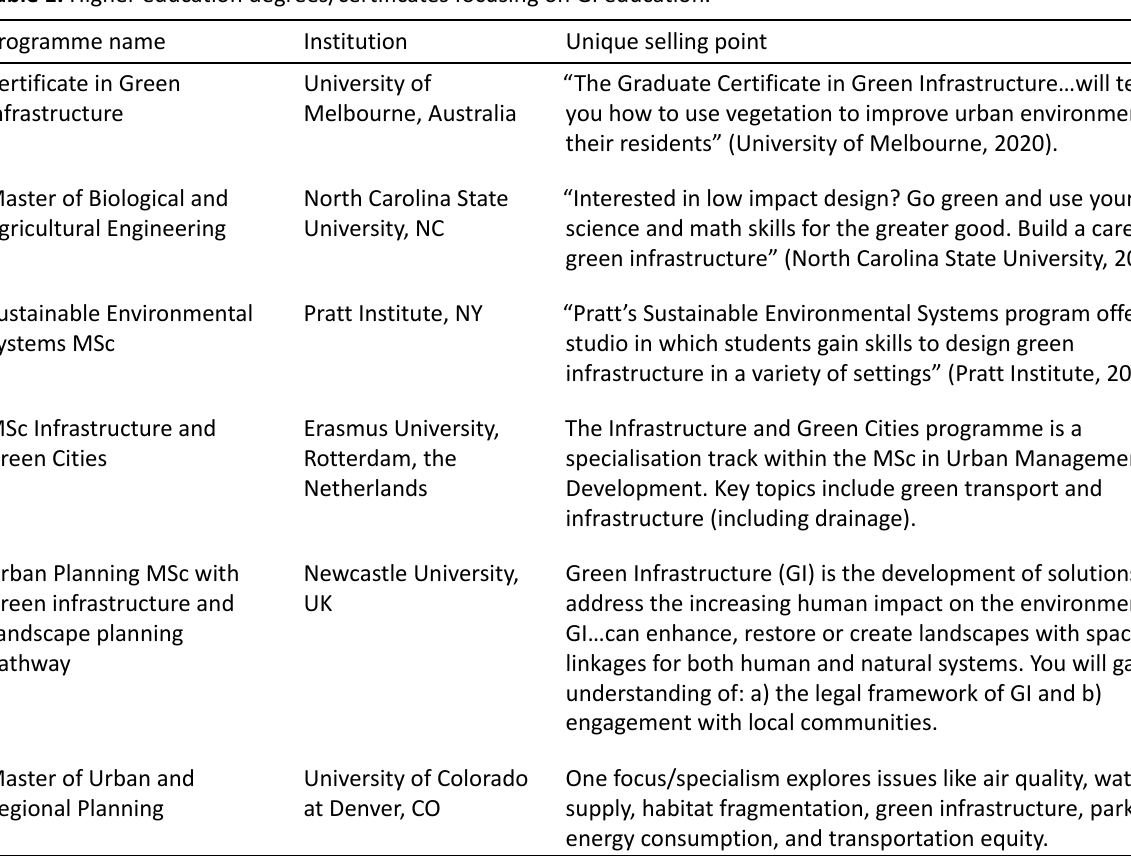
Table 1. Higher education degrees/certificates focusing on GI